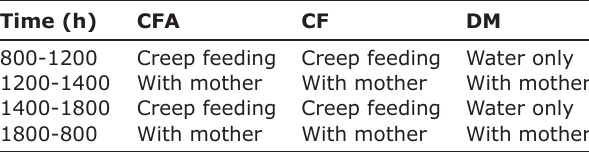
Table-2: The feeding program of the experimental groups; CFA, CF and